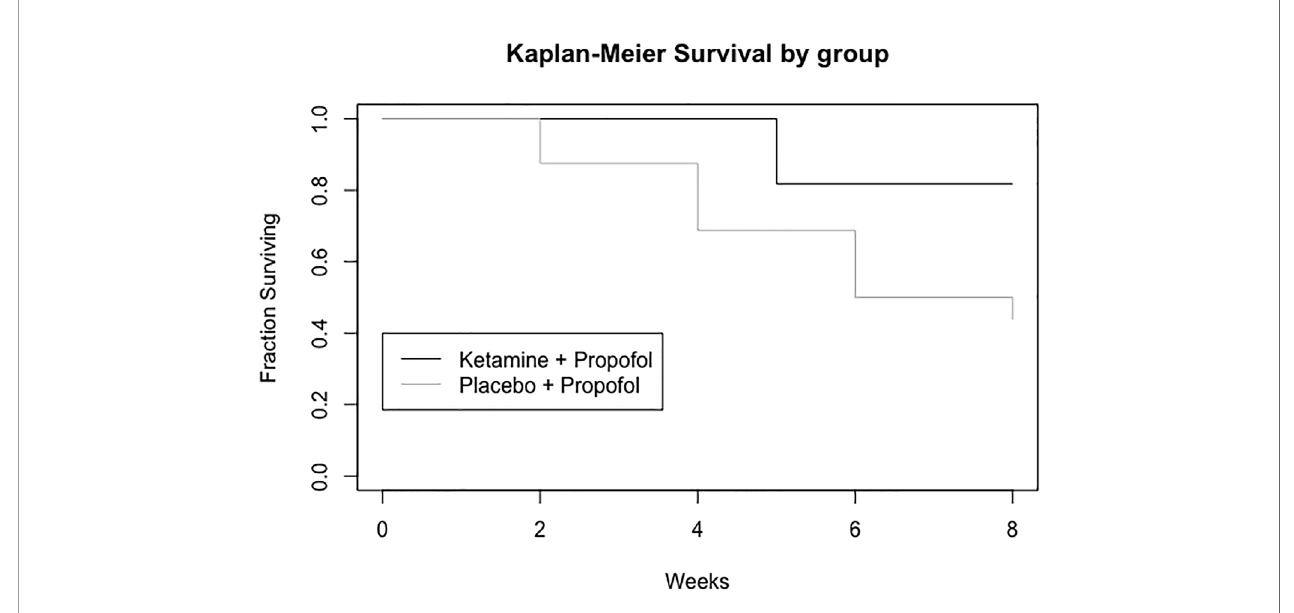
FIGURE 2 | Number of patients who achieved remission (MADRS score < 10) throughout the study period while receiving placebo + propofol or ketamine + propofol during electroconvulsive therapy (ECT).